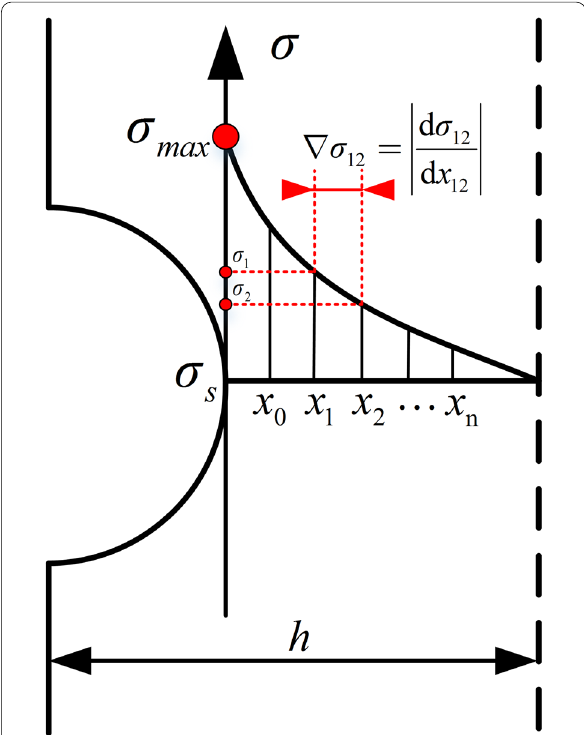
Figure 2 FE-based calculation on stress concentration of a notched